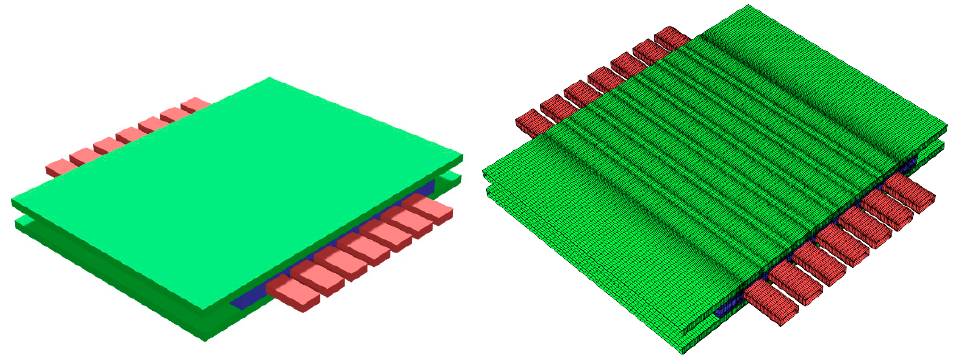
Figure 2. Fluid domain and its discretization.